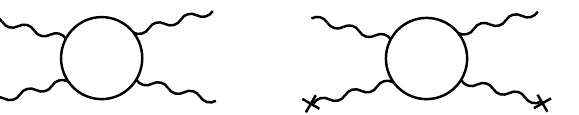
Figure 1. Lowest order nonlinear elementary processes in vacuum. ( Left ) light-by-light elastic scatter- ing. ( Right ) vacuum magnetic